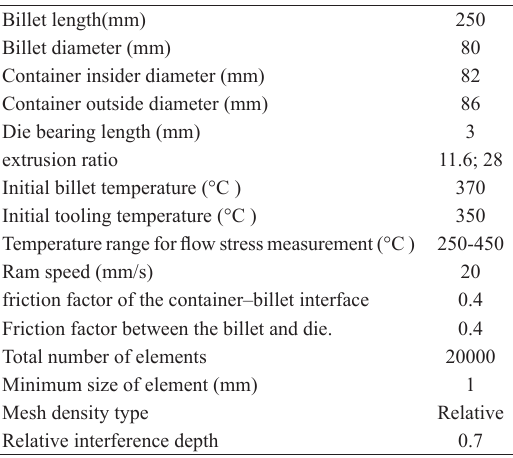
Figure 3. True stress/true strain curves obtained from the compression tests at different strain rates with the pre-set strain rate of 1 s −1 . Table 2. Simulation and experimental